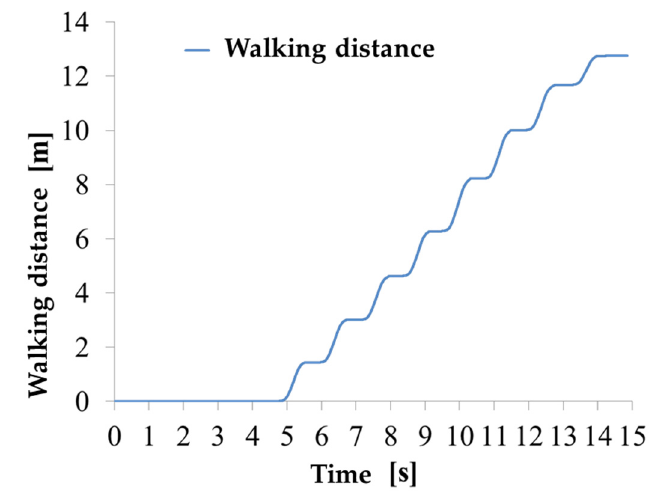
Figure 12. Walking distance of IMU on the ankle.